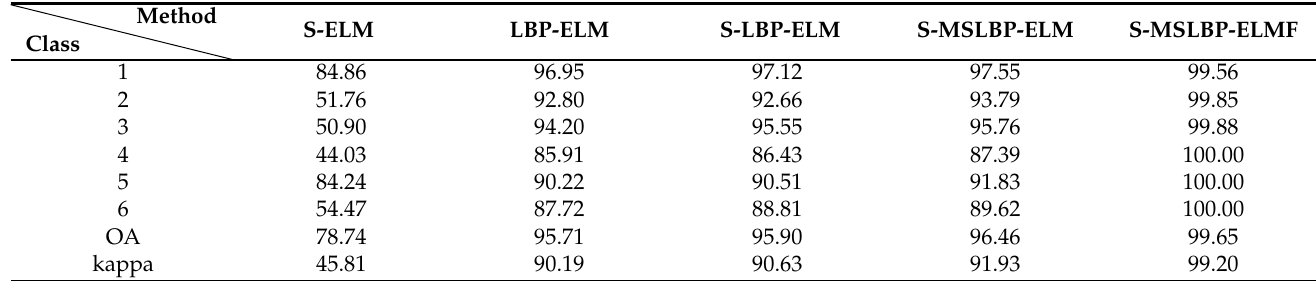
Table 7. Interpretation accuracies of different methods on dataset with complex terrain areas dateset